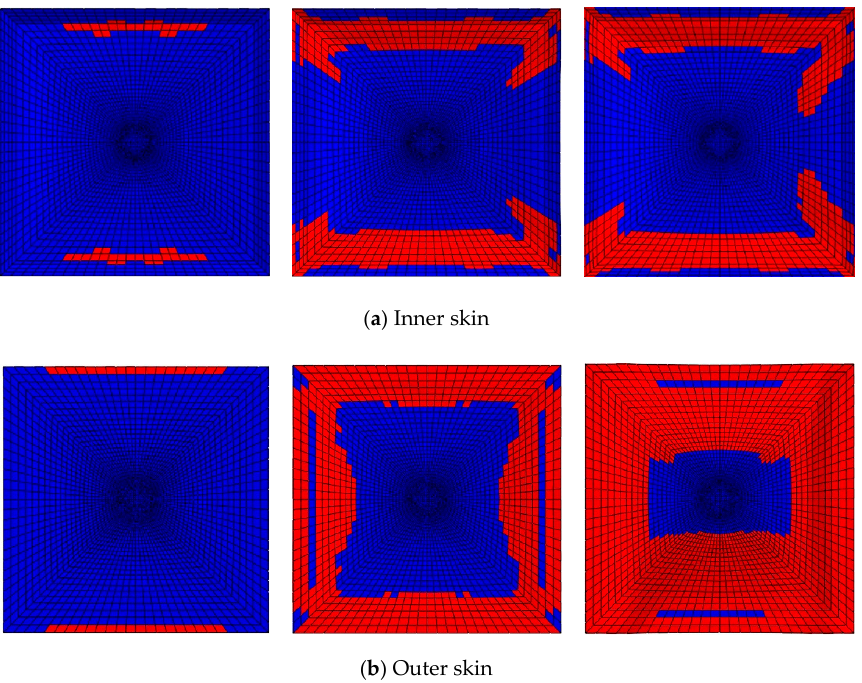
Figure 17. Honeycomb damage propagation in the CD40 Model. ( a ) the damage propagation of inner skin; ( b ) the damage propagation of outer skin.